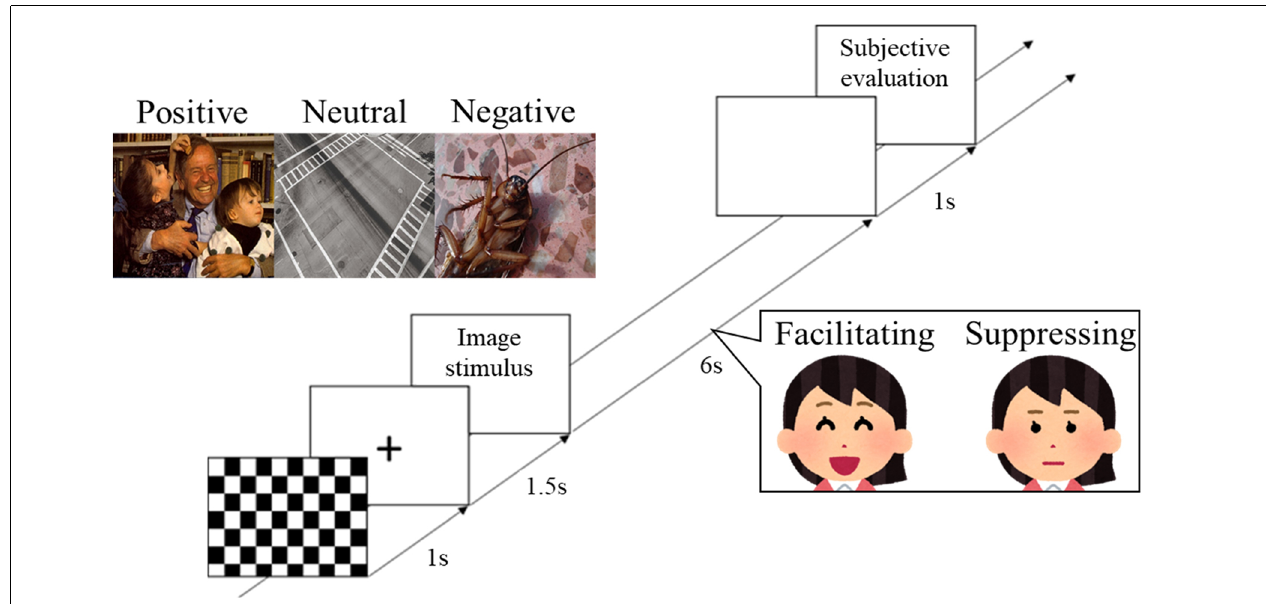
FIGURE 1 | Protocol for stimulus presentation and facial expression responses. The three labeled images show examples of the image stimuli from international affective picture system (IAPS) and open affective standardized image set (OASIS) that were presented in the experiment (positive: IAPS, 2340; neutral: OASIS, Crosswalk 1; negative: OASIS, Cockroach 1). The two images of the woman show the facial expression task that was performed by participants during presentation of the image